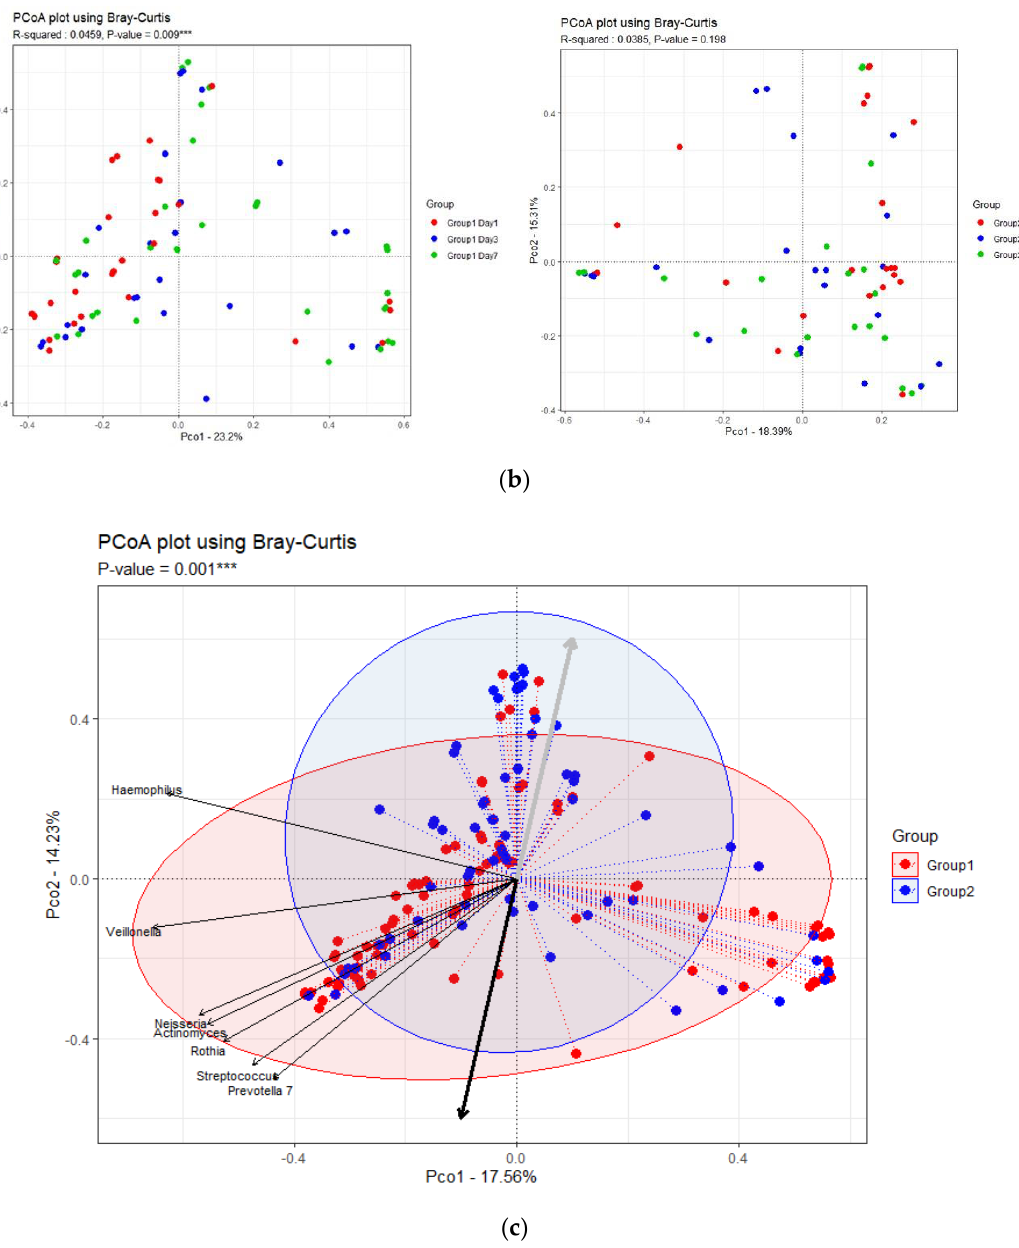
Figure 3. Longitudinal changes in the respiratory microbiota in intubated patients with pneumonia. ( a ) Changes in α-diversity between days 1 and 7 after initiation of mechanical ventilation. The Shannon diversity index and Simpson index are measures of α-diversity. Left, successful extubation group (Group1); right, failed extubation group (Group2). ( b ) PCoA plots of the Bray–Curtis distance of the respiratory microbiota. Each color represents the day. Left, successful extubation group (Group1); right, failed extubation group (Group 2). ( c ) Changes in Bray–Curtis distance are shown as red dashed lines for the successful extubation group, and blue dashed lines for the failed extubation group. Black and gray arrows indicate mean changes in the successful extubation and failed extubation groups between two time points. Logistic regression analysis showed that the changes in PCo2 significantly differed between the two groups ( p = 0.001).